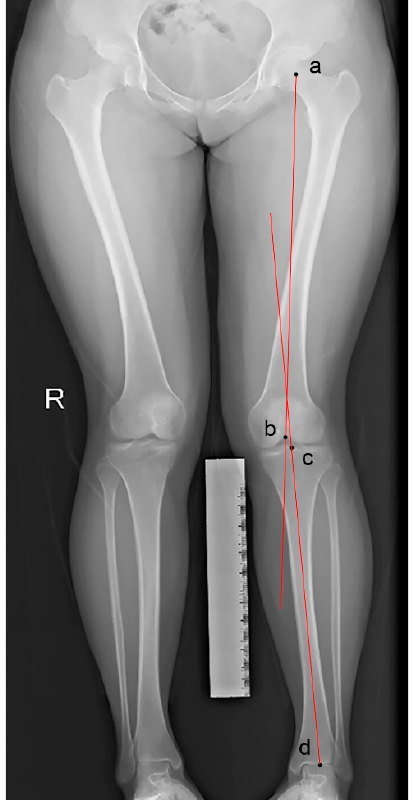
Figure 4. Hip–knee–ankle (HKA) angle measured by a weight-bearing full-leg radiograph. The points represent the center of the femoral head ( a ), the femoral condyles ( b ), the tibial plateau ( c ), and the ankle joint ( d ). It is the angle formed between the femoral axis (ab) and the tibial axis (cd).